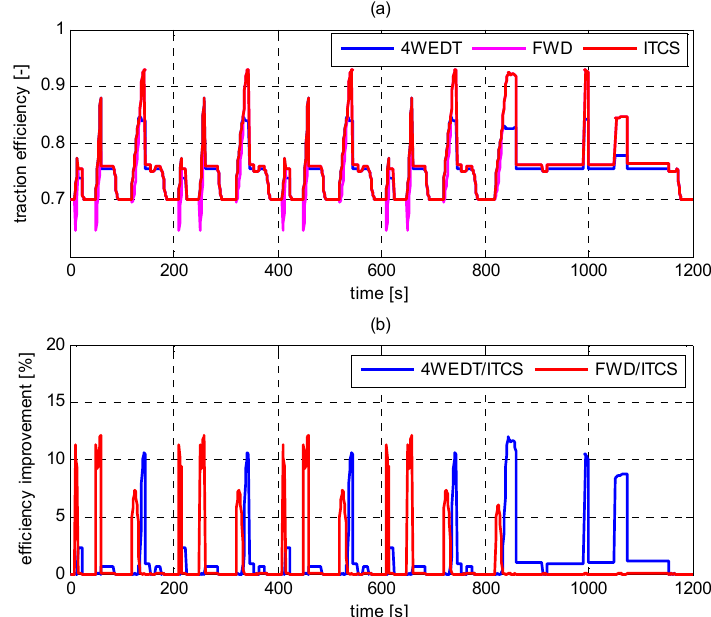
Figure 6. Efficiency and its improvement rate: ( a ) traction efficiency of different allocation approaches; and ( b ) efficiency improvement.